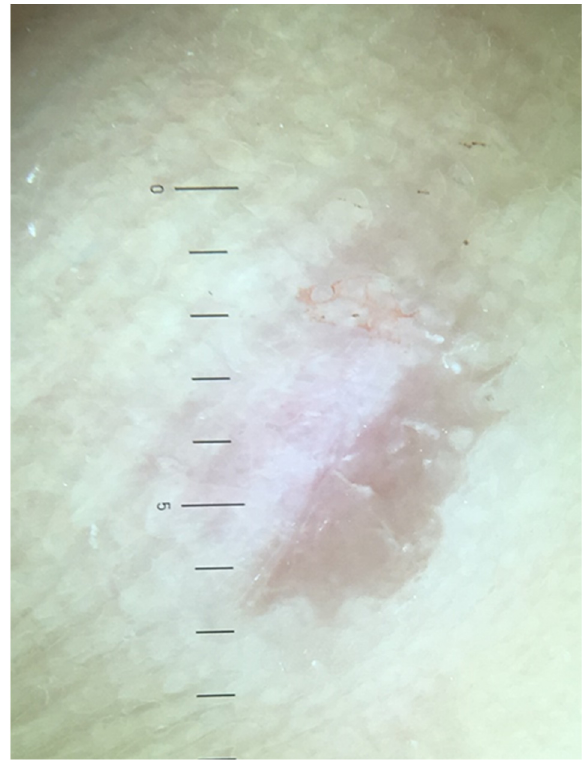
Figure 2. Dermoscopy of callus showing a central featureless reddish area.